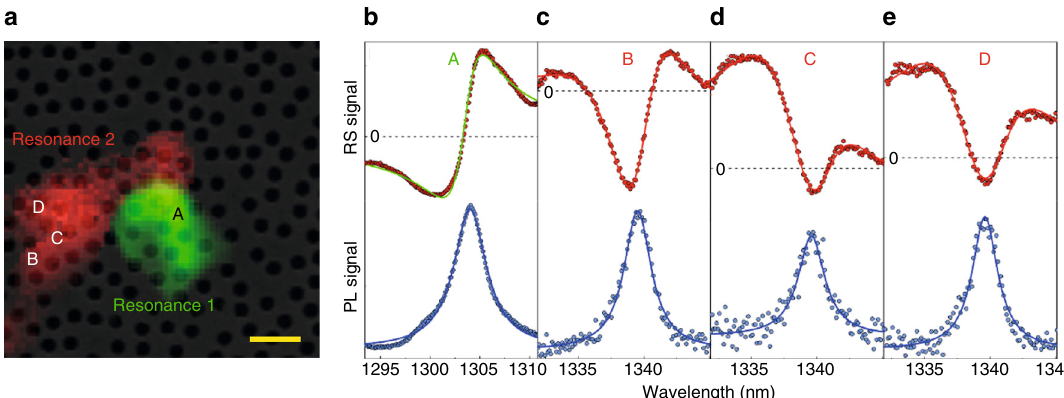
Fig. 5 Generalized Fano lineshapes in a disordered photonic medium. a Scanning electronic microscope image of the disordered GaAs slab along with the photoluminescence (PL) intensity maps of two spectrally separated resonances superimposed in green and red, respectively. The scale bar is 500 nm. b – e Comparison between PL and resonant-scattering (RS) spectra detected at the positions A, B, C, D. The PL (RS) data are plotted as blue (red) points. PL data are fi tted by Lorentzian (blue lines). b The RS spectrum of resonance 1 is reproduced by a standard Fano lineshape (green line). c – e The RS spectra of resonance 2 are reproduced by generalized Fano pro fi les (red lines). At every position, the central frequency and the broadening of PL and RS spectra are in